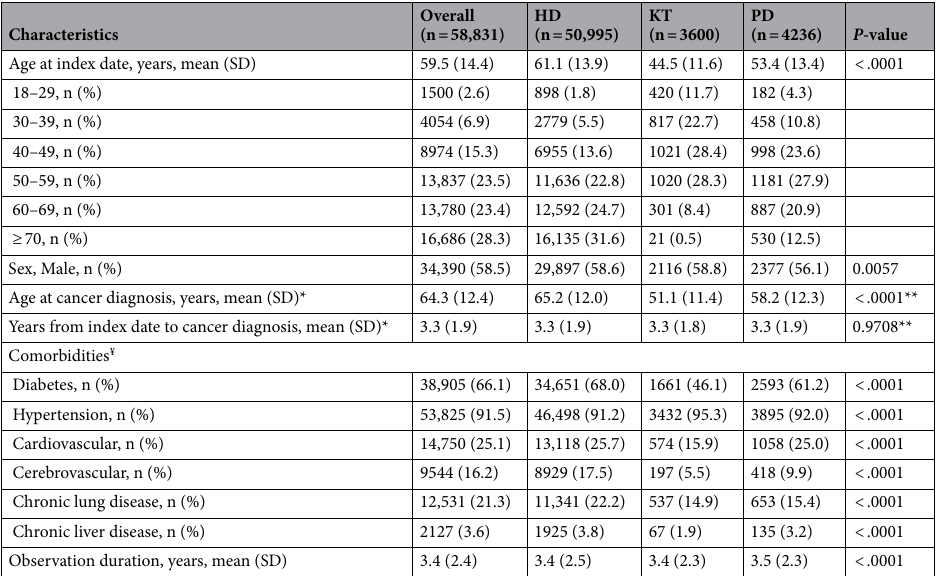
Table 1. Baseline characteristics of the study population. In case of patients (n = 2066/3600) who received either HD or PD before KT, mean (SD) time from HD or PD to KT is 115 (91.3) days. SD, standard deviation; HD, hemodialysis; PD, peritoneal dialysis; KT, kidney transplant. *Analyzed among patients with cancer (n = 3292) only. ** P -value was based on the analysis of variance (ANOVA) test; otherwise, the chi-square test. ¥ Comorbidities were observed within 1 year before index